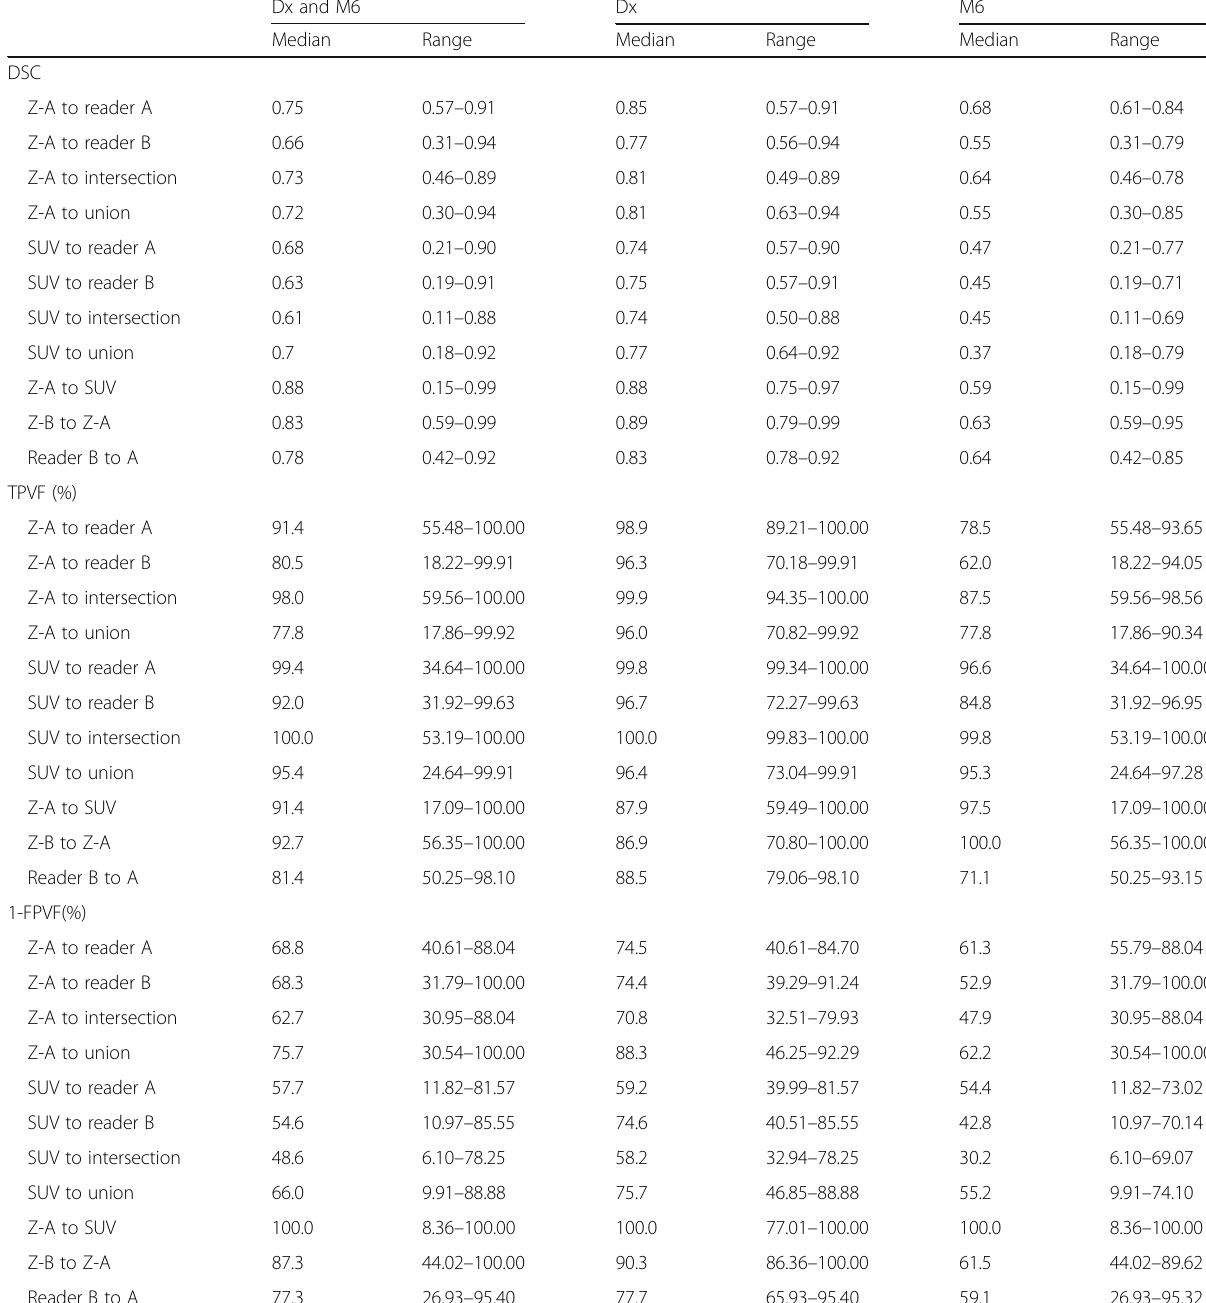
Table 2 Summary of comparisons between independent readers, reader A and reader B, and automated thresholding segmentations using the Z -score (Z-A and Z-B) and SUV > 1 (SUV). Values for dice similarity coefficient (DSC), true positive volume fraction (TPVF) and 1 minus false positive volume fraction (1-FPVF) are